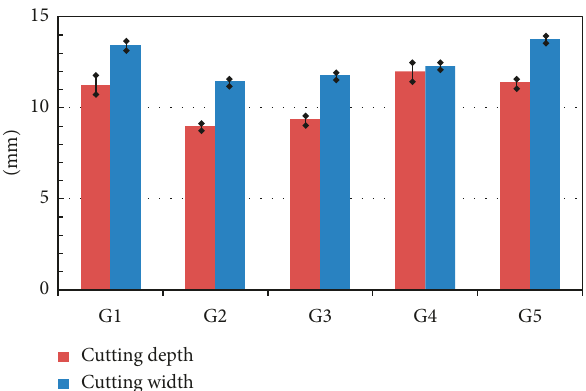
Figure 6: Comparison of cutting depth and width results at 10.7g/s of abrasive feed rate.